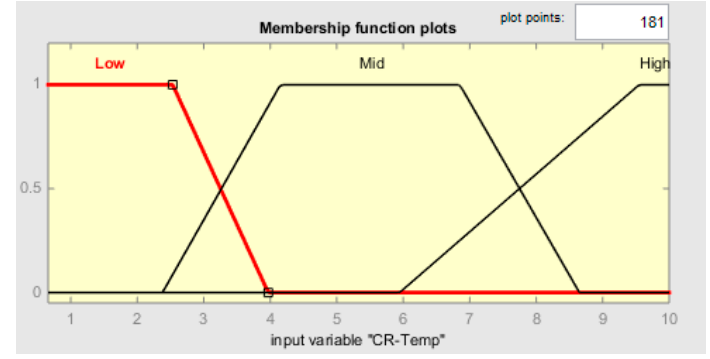
Figure 9. CR-Temp MF plot.